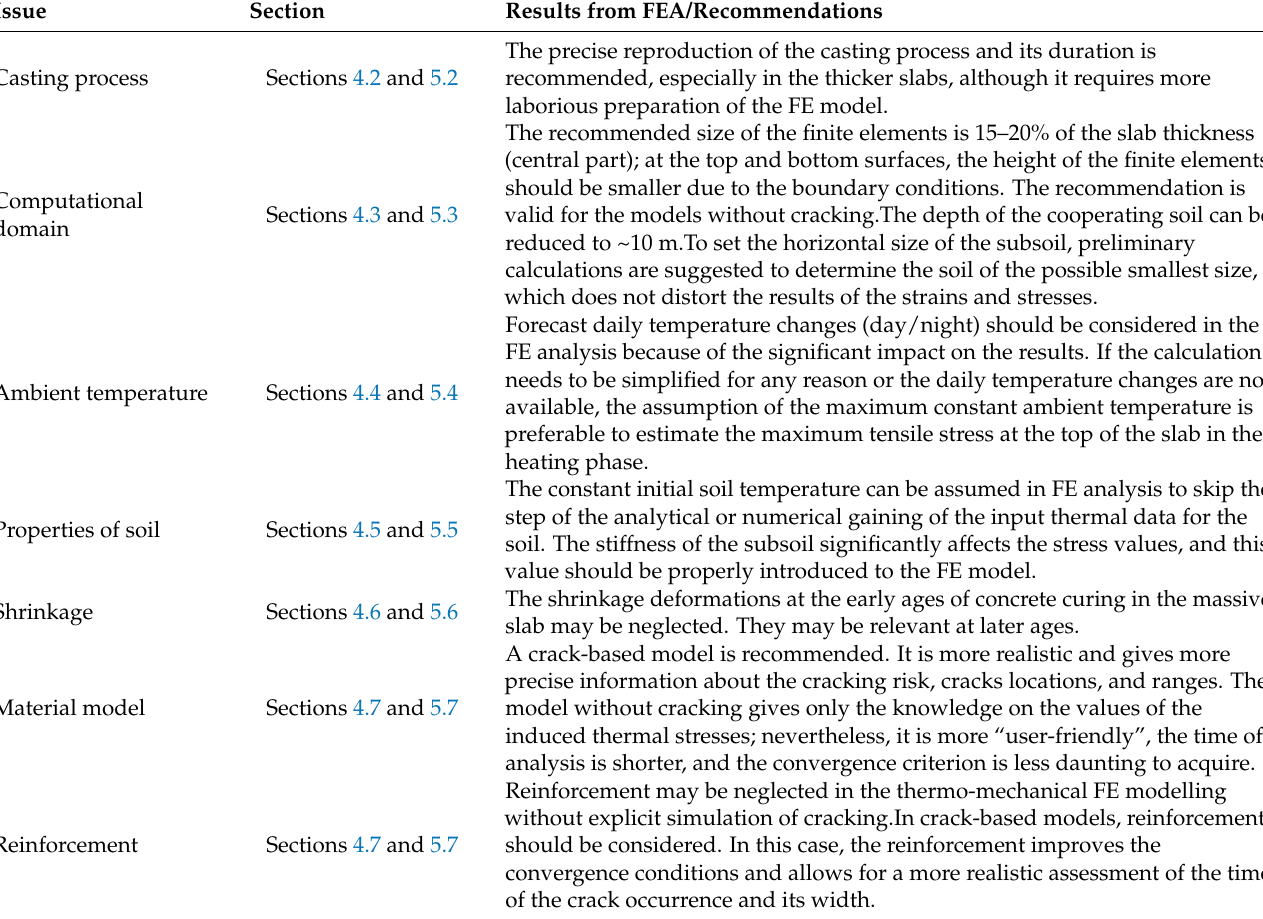
Table 3. Summary of the results and recommendations for the FEA of massive foundation slabs at early